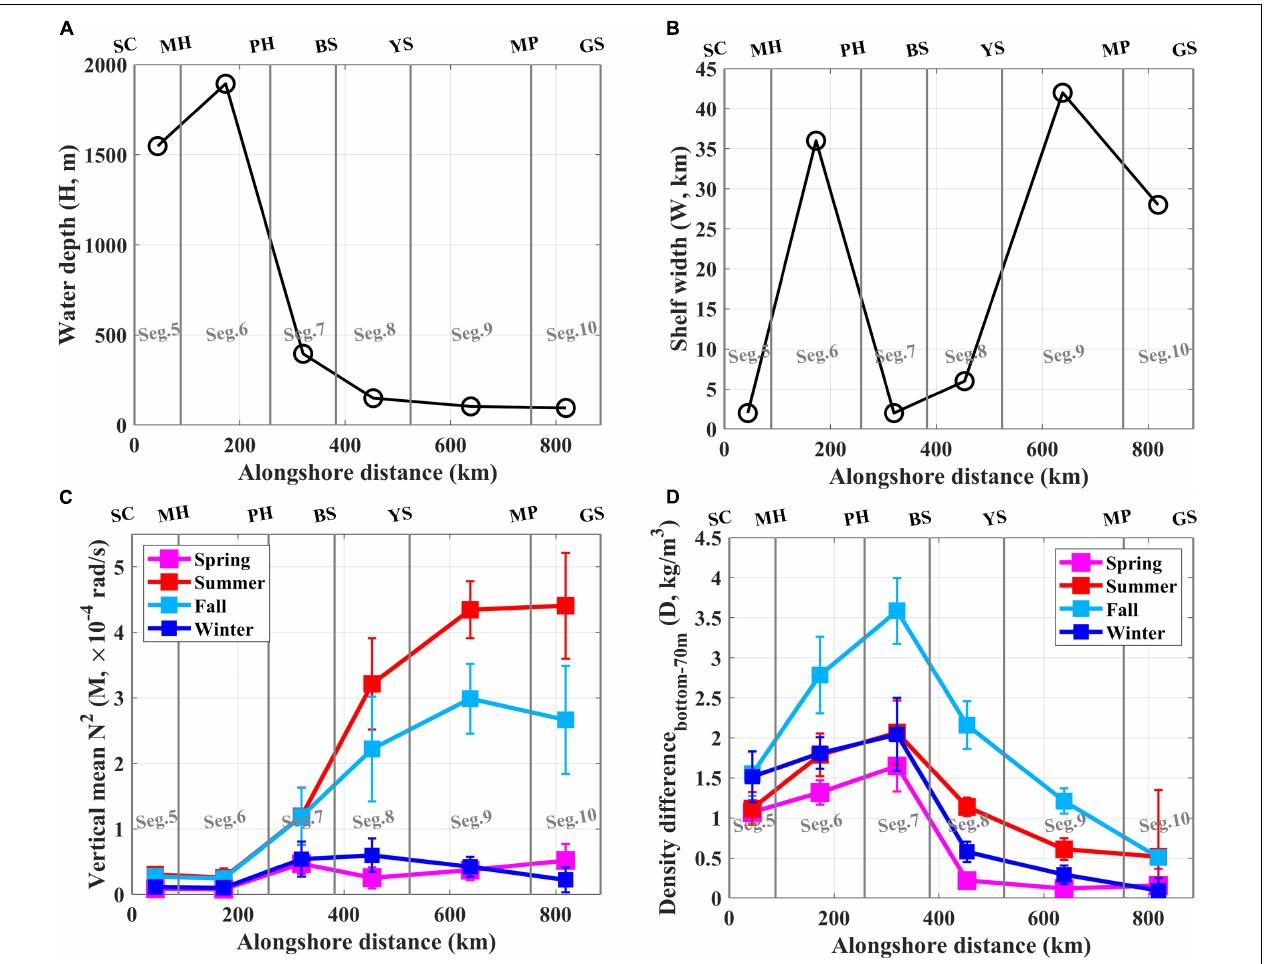
FIGURE 8 | (A) Water depth ( H ) and (B) shelf width ( W ) as a function of the alongshore distance, (C) vertical mean N 2 ( M ), and (D) vertical density difference ( D ) between the bottom and the lower boundary of the seasonal thermocline (70 m) as a function of the alongshore distance for four seasons. For (C,D) , vertical error bars denote the uncertainties over an interannual